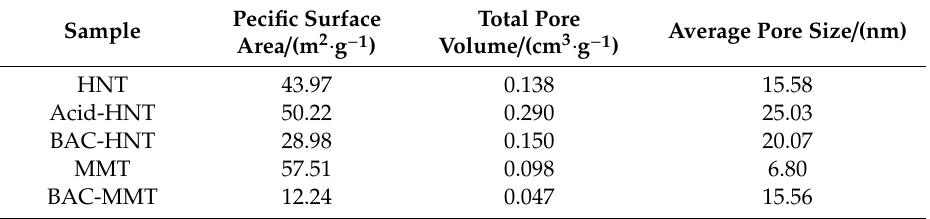
Figure 6. Adsorption–desorption isotherms of ( a ) HNT- and ( b ) MMT-loaded BAC before and after. Table 2. Pore structure parameters of HNT and MMT from N2 adsorption–desorption isotherms.